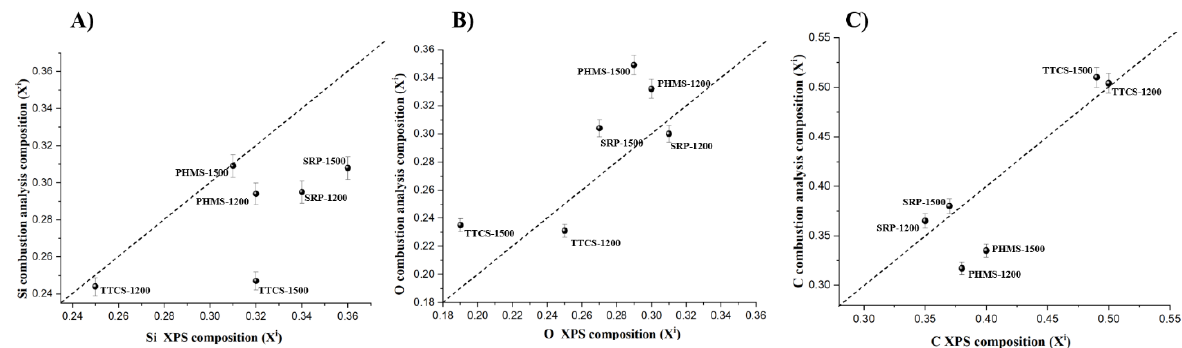
Figure 3. Comparison of composition by XPS and combustion analysis. ( A ) Silicon, ( B ) Oxygen and ( C ) Carbon.